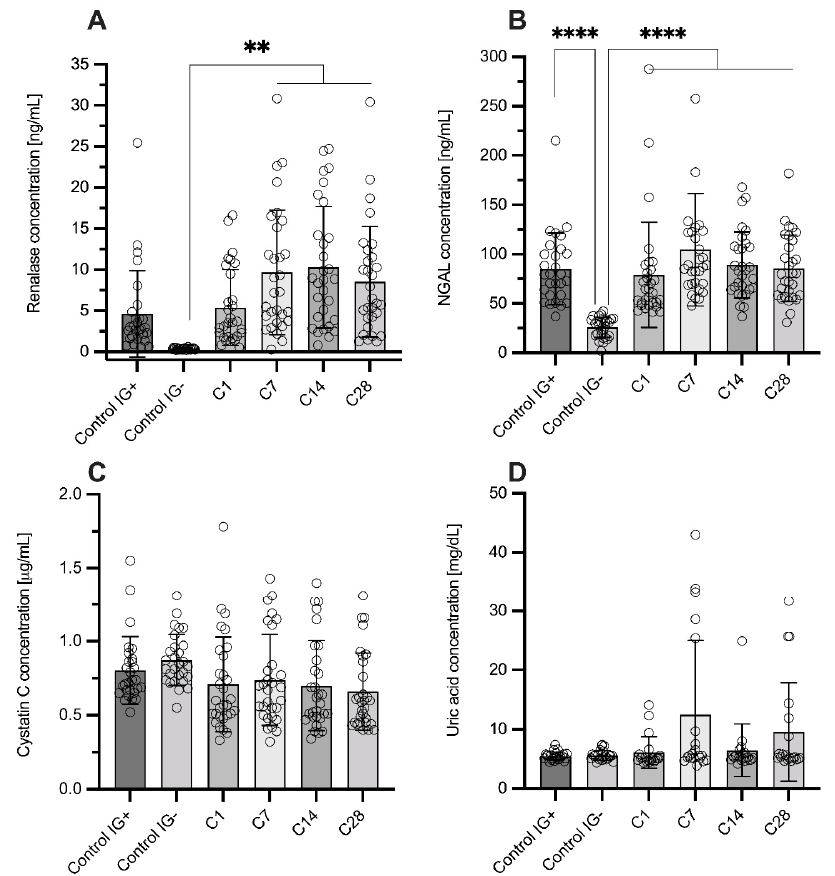
Figure 2. Renalase ( A ), neutrophil gelatinase-associated lipocalin ( B ), cystatin C ( C ), and uric acid ( D ) levels in analyzed groups. ** p < 0.01; **** p < 0.001.